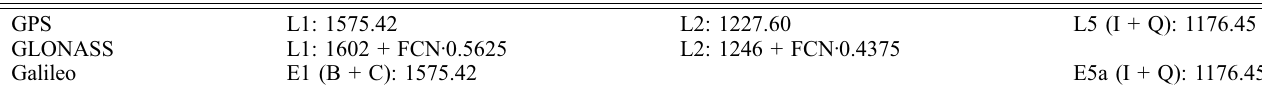
Table 1. The table lists the frequencies in MHz of the GNSS and the particular channels studied in this article. GPS and Galileo use code division multiple access and therefore share one frequency for all satellites per channel. GLONASS uses frequency division multiple access and therefore has individual frequencies per channel per satellite given by the base frequency shifted by the frequency channel number